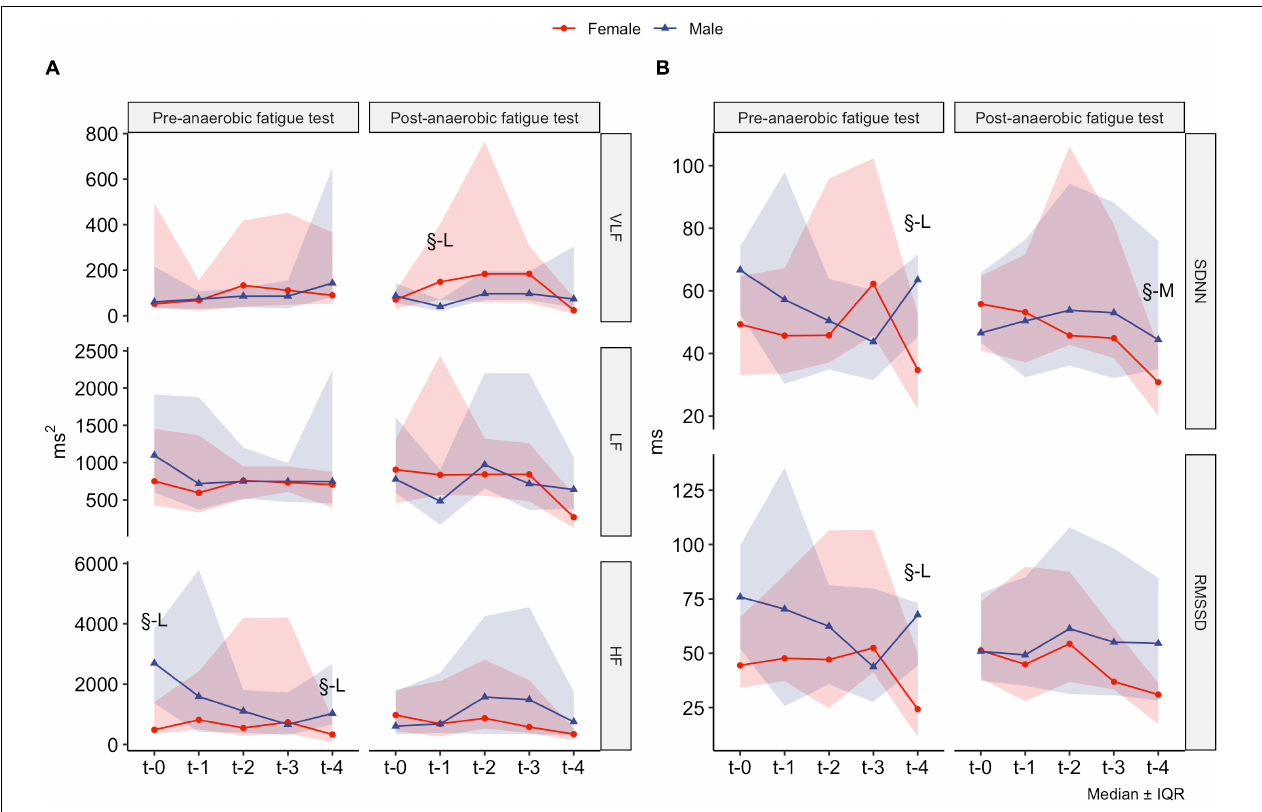
FIGURE 3 | Heart rate variability parameters were compared by sex within each time. (A) Frequency domain; (B) time domain. The median of the values is presented in a red line for the females and blue for the males, while the red and blue areas represent the corresponding interquartile range. § Significantly different ( p < 0.05) and rank-biserial correlation code were: M, moderate; L,